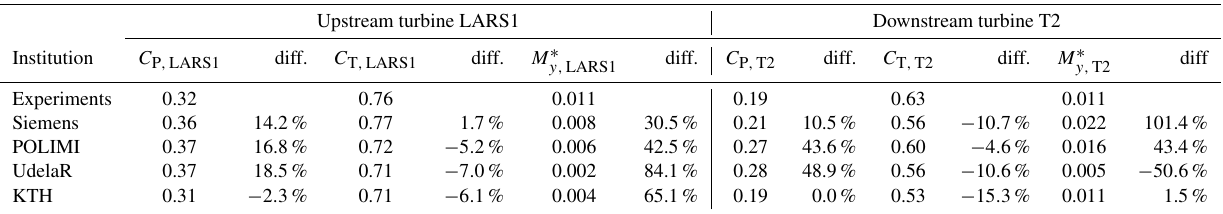
Table 3. Numerical values of power coefficient C P , thrust coefficient C T , and normalized yaw moment M ∗ y and deviations of predictions to measurements in percent for test cases 1 and 2.